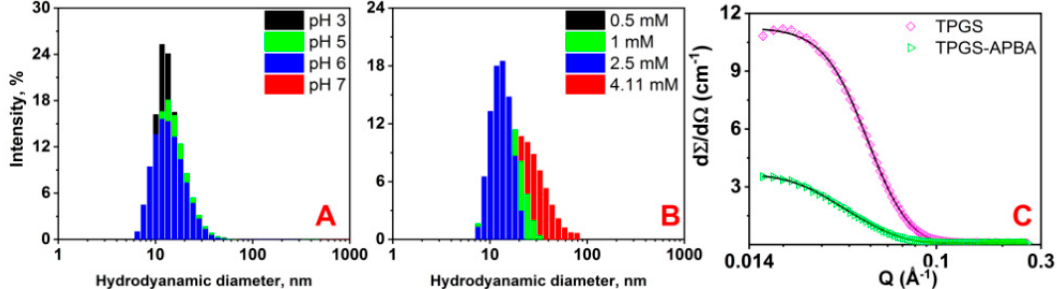
Figure 2. DLS data of TPGS-APBA micelles showing the effect of pH changes ( A ) and PLX encapsulation ( B ). Difference in neutron scattering profiles of TPGS and TPGS-APBA is shown in ( C ). Solid lines correspond to the fits in core-shell model. The concentration was fixed as 2%.